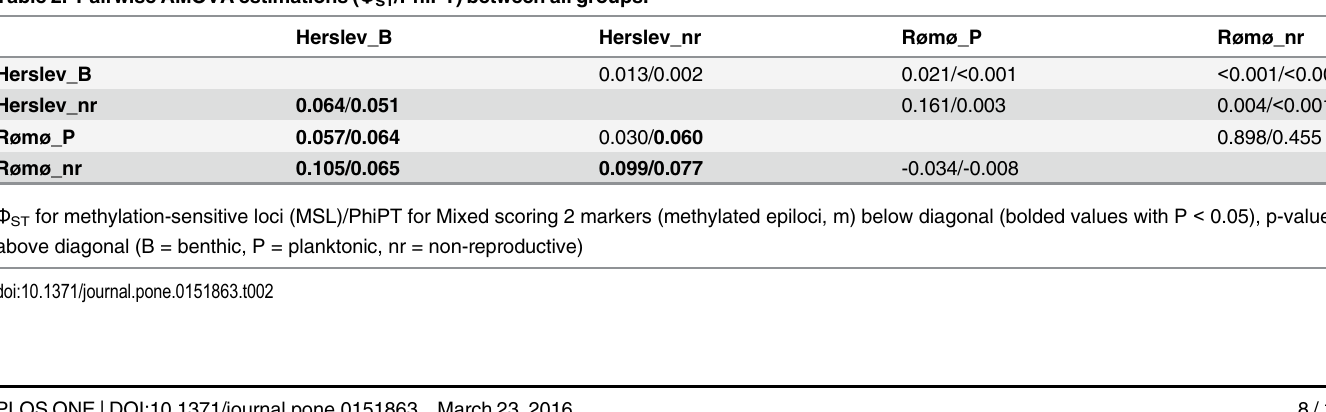
An alternative scoring method, the mixed scoring transformation ( ‘ Mixed Scoring 2 ’ , [28]) of the data revealed altogether 395 markers or epiloci. Analyses with this scoring of the data produced similar results as the first scoring method, described above. AMOVA suggested epi- genetic differences among groups (PhiPT = 0.049, P < 0.001) and all pairwise comparisons were significant except between gravid and non-gravid females from Rømø, which did not show differences in their methylation profiles (Table 2). Epigenetic diversity was highest in Rømø (in % polymorphic markers & private markers and Shannon ’ s diversity index, Table 3) and lowest in non-reproductive females from Herslev.